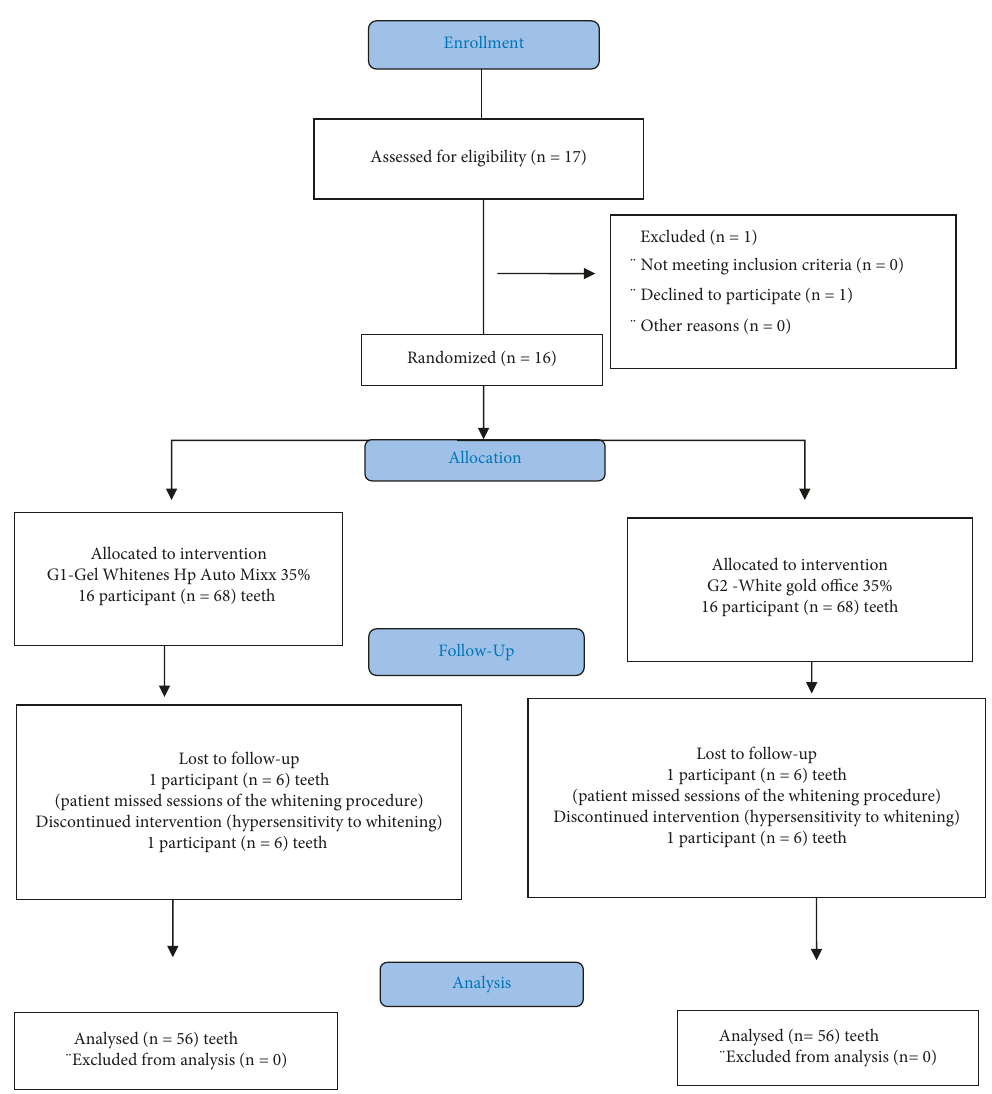
Figure 1: Flow diagram of study inclusion criteria. Table 1: Distribution of the teeth that were submitted to in vivo SpO 2 p reading using the PO, regardless of the arch (upper or lower) and the dental groups evaluated ∗